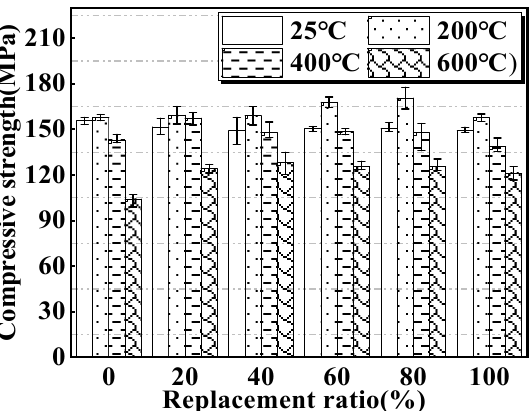
Figure 6. Compressive strengths of MUHPC after different high-temperature exposures. With increases in temperature to 400 ◦ C and 600 ◦ C, the compressive strengths of MUHPC began to drop gradually. For example, after exposure to 600 ◦ C, the compressive strengths of R0, R20, R40, R60, R80, and R100 specimens decreased by 33.3%, 18.4%, 14.1%, 16.6%, 16.6%, and 18.8%, respectively. Typical images of MUHPC specimens after different high-temperature exposures are shown in Figure 7. The appearances of the specimens after 200 ◦ C or 400 ◦ C exposure were almost unchanged, whereas after 600 ◦ C exposure, the specimens exhibited obvious cracks. The cracking of MUHPC can be explained by the transformation of Ca(OH) 2 to CaO at 400–600 ◦ C, which leads to the expansion of hardened cement paste followed by shrinkage [58]. Calcium hydroxide can be converted into lime and water vapor during heating, and serious damages are inflicted by lime expansion during cooling, which may be the main reason for the decline in concrete strength.